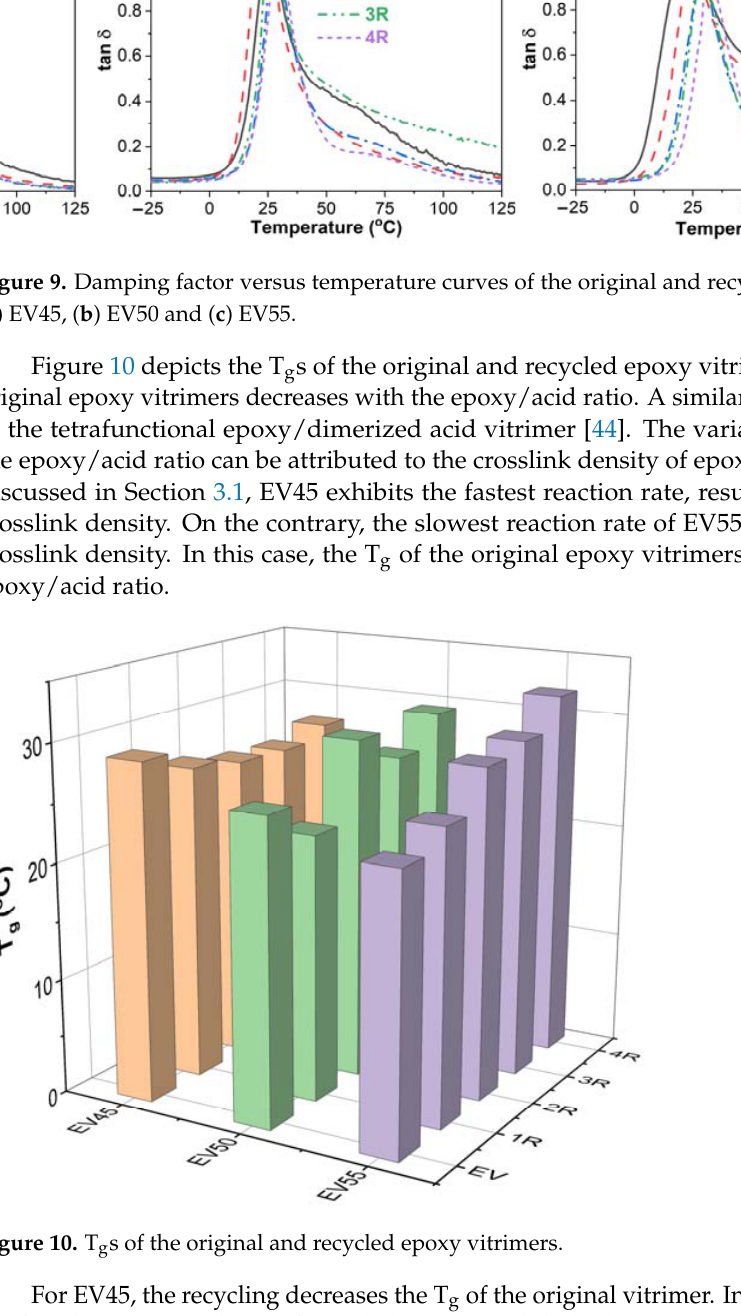
Figure 11. Stress–strain curves of the original and recycled epoxy vitrimers: ( a ) EV45, ( b ) EV50 and ( c ) EV55. Figure 12 presents the tensile strength of the original and recycled epoxy vitrimers. The tensile strength of the original vitrimers decreases with the epoxy/acid ratio. How ‐ ever, a contrary trend was shown in the tetrafunctional epoxy/dimerized acid vitrimers